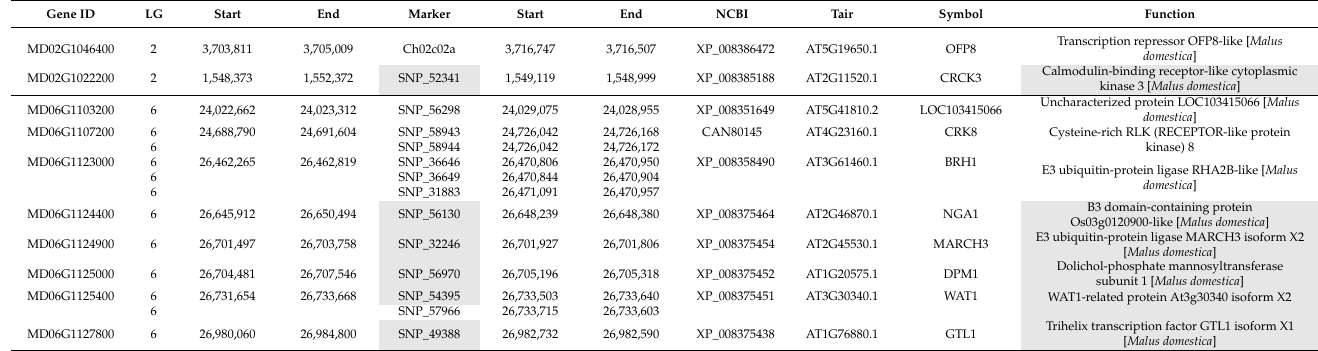
Table 3. Putative candidate genes associated with the significant SNP markers and the SSR marker Ch02C02a and their respective